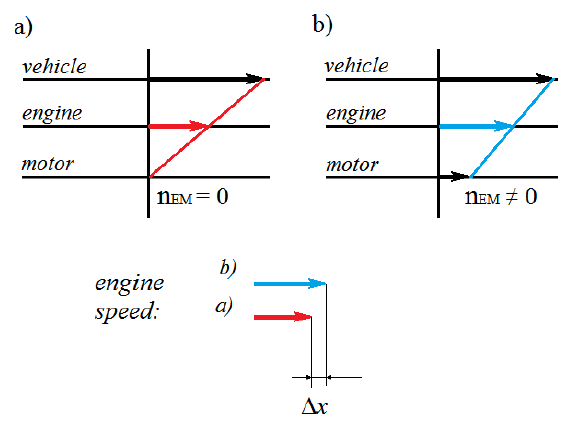
Figure 12. Illustration of the difference between the required speed of the engine (carrier) in a) the reference vehicle and b) the proposed model